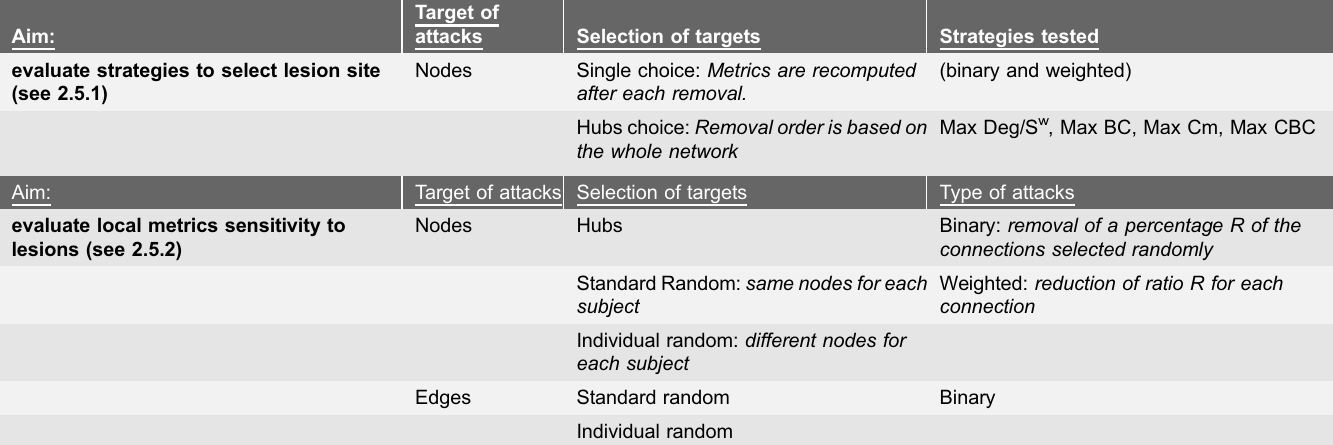
Table 2. Summary description of the different lesion methods used and their characteristics. Aim: